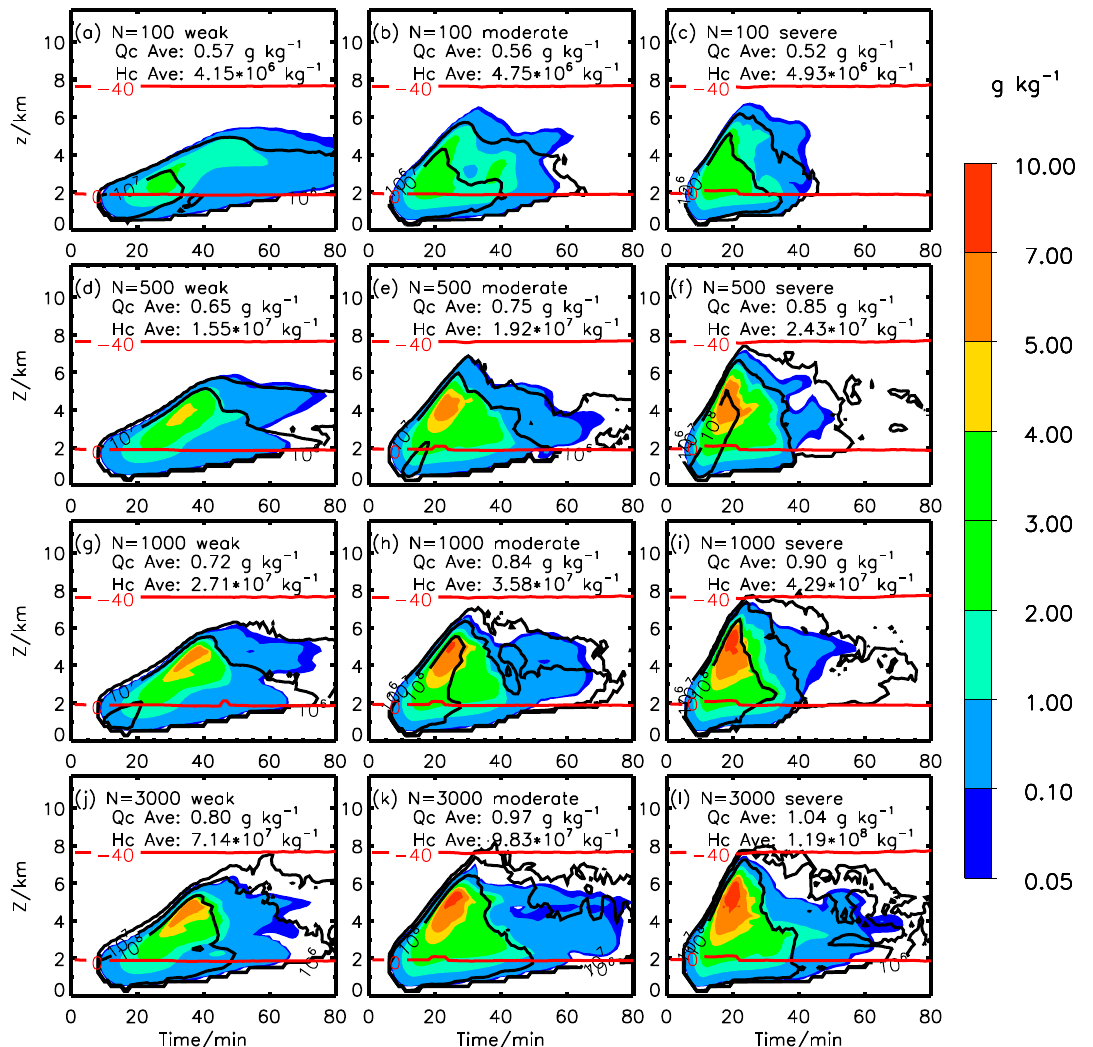
Figure 3. Spatial and temporal distribution of the mixing ratio and the number concentration of cloud droplet for initial aerosol concentrations: ( a – c ) 100 cm − 3 , ( d – f ) 500 cm − 3 , ( g – i ) 1000 cm − 3 , ( j – l ) 3000 cm − 3 ; the number represents the average mixing ratio (Qc Ave) and the average number concentration (Hc Ave), and below is the same; the red solid line represents the isotherm ( − 40 and 0 ◦ C); the black contour respectively represents: 10 6 , 10 7 , 10 8 , and 10 9 kg − 1 .